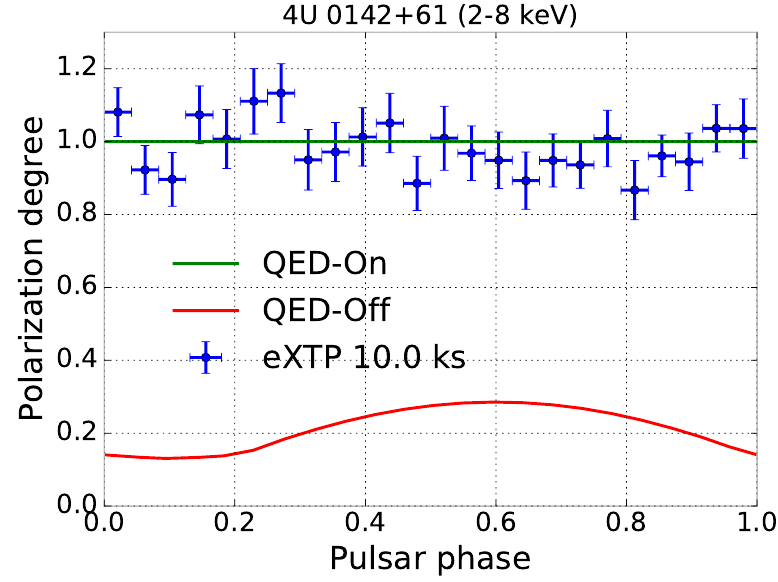
Figure 3. The expected degree of polarization from the magnetar 4U 0142+61 from the thermal emission, assuming a two-black-body model in which the radiation is initially fully polarized in the perpendicular mode. The crosses give the results for a short simulated observation with eXTP (10 ks). The results for IXPE are similar with a 30-ks